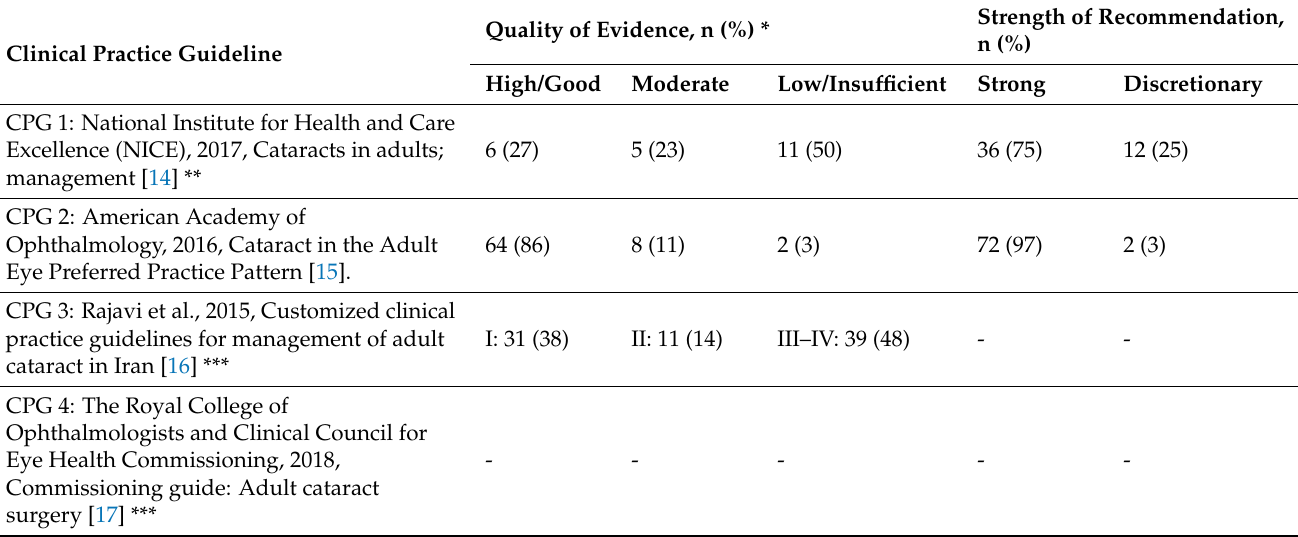
Table 4. Quality of evidence and strength of recommendation of the included Clinical Practice Guidelines